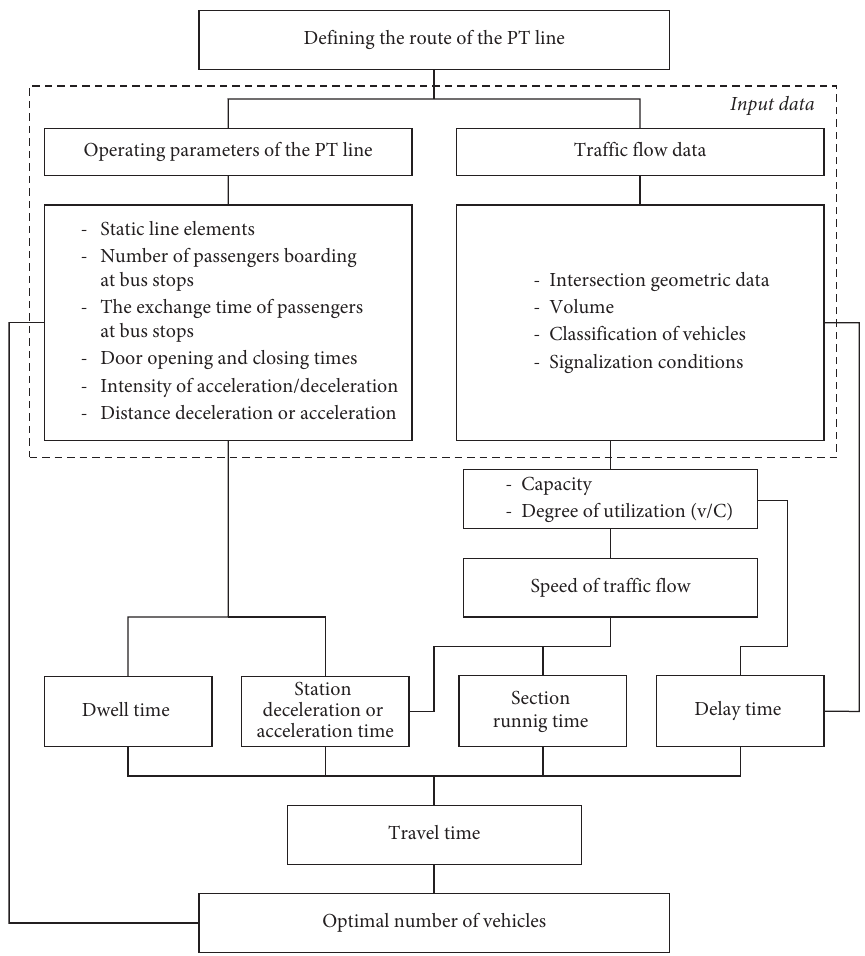
Figure 1: Diagram flow of the model